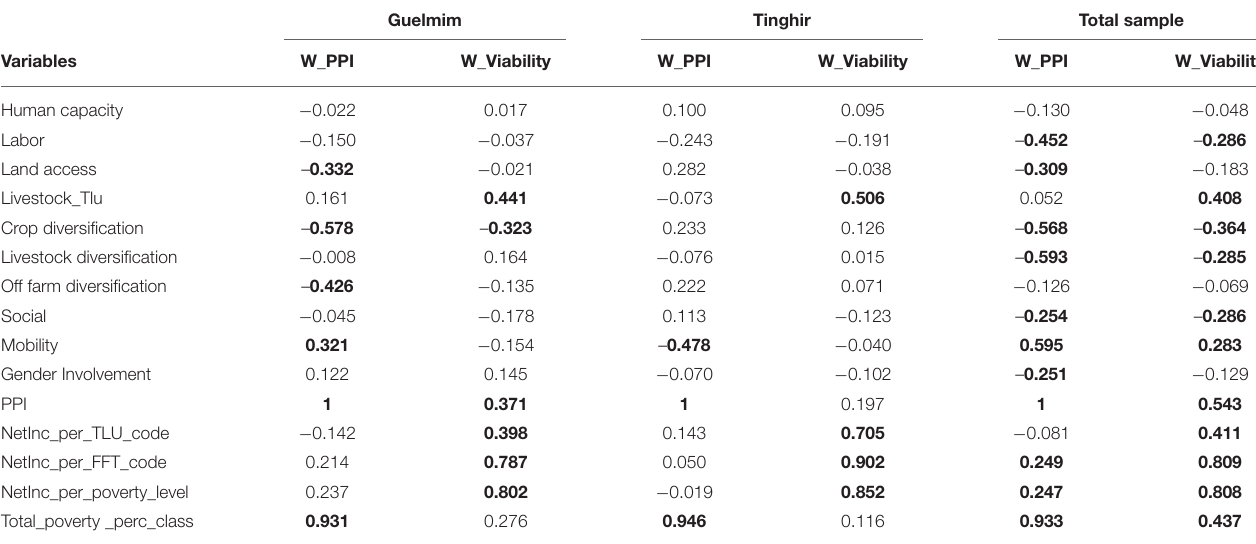
Values in bold are different from 0 at a significance level alpha =